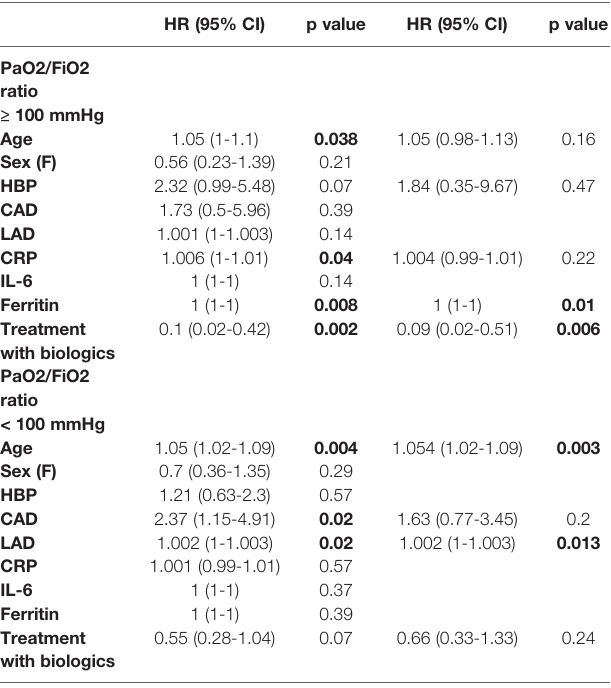
TABLE 8 | Baseline univariate and multivariate predictors of mortality in patients with a PaO2/FiO2 ratio < 100 mmHg and ≥ 100 mmHg. HR (95% CI) p value HR (95%